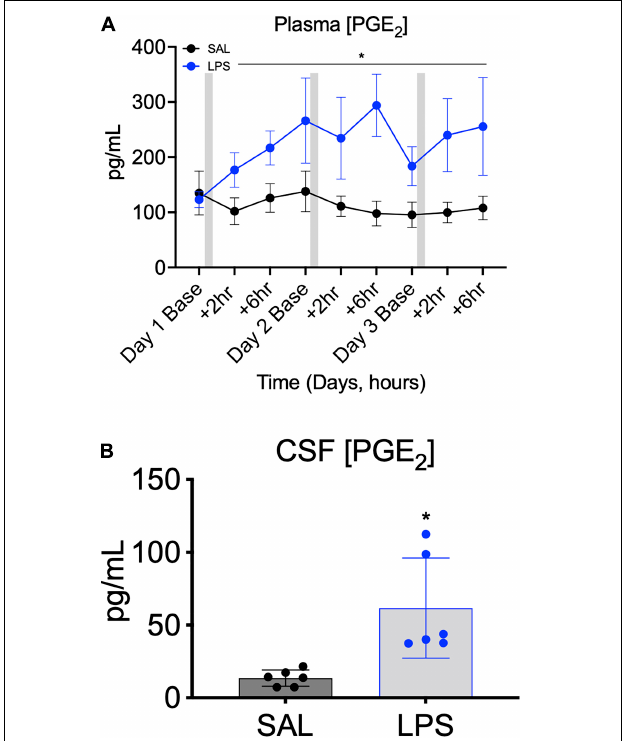
FIGURE 3 | Plasma PGE 2 concentrations measured across the 3 days of SAL/LPS infusions at baseline (before infusions), + 2 and + 6 h after infusions (A) . Gray bars indicate SAL or LPS infusion on each day after baseline sampling. Data are means ± SEM. Cerebrospinal fluid (CSF) PGE 2 concentration in SAL (control = black, n = 6) and LPS-exposed (blue, n = 6) fetuses measured on experimental day 5 (4 days after starting infusions, B ). Data are means ± SD, * P < 0.05 vs. control.